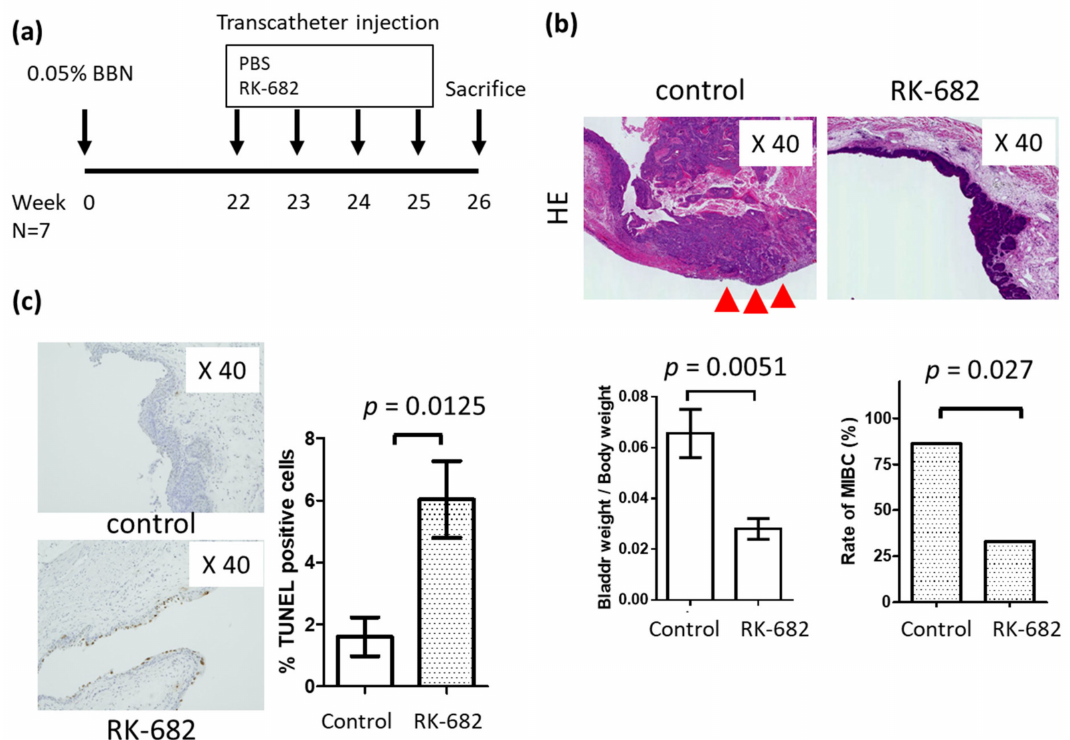
Figure 4. Intravesical injection of RK-682 inhibits in vivo tumor growth in the mouse N-butyl- N-(4-hydroxybutyl) nitrosamine (BBN)-induced bladder cancer implant model. ( a )